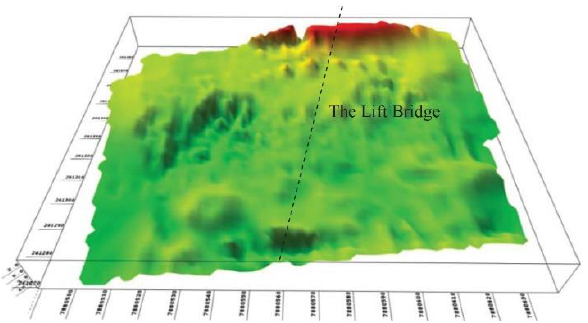
Figure 8. Three Dimensional View of the Second Study (Under the Lift Bridge) Area Using the AUV IVER3 Data on SonarWiz5